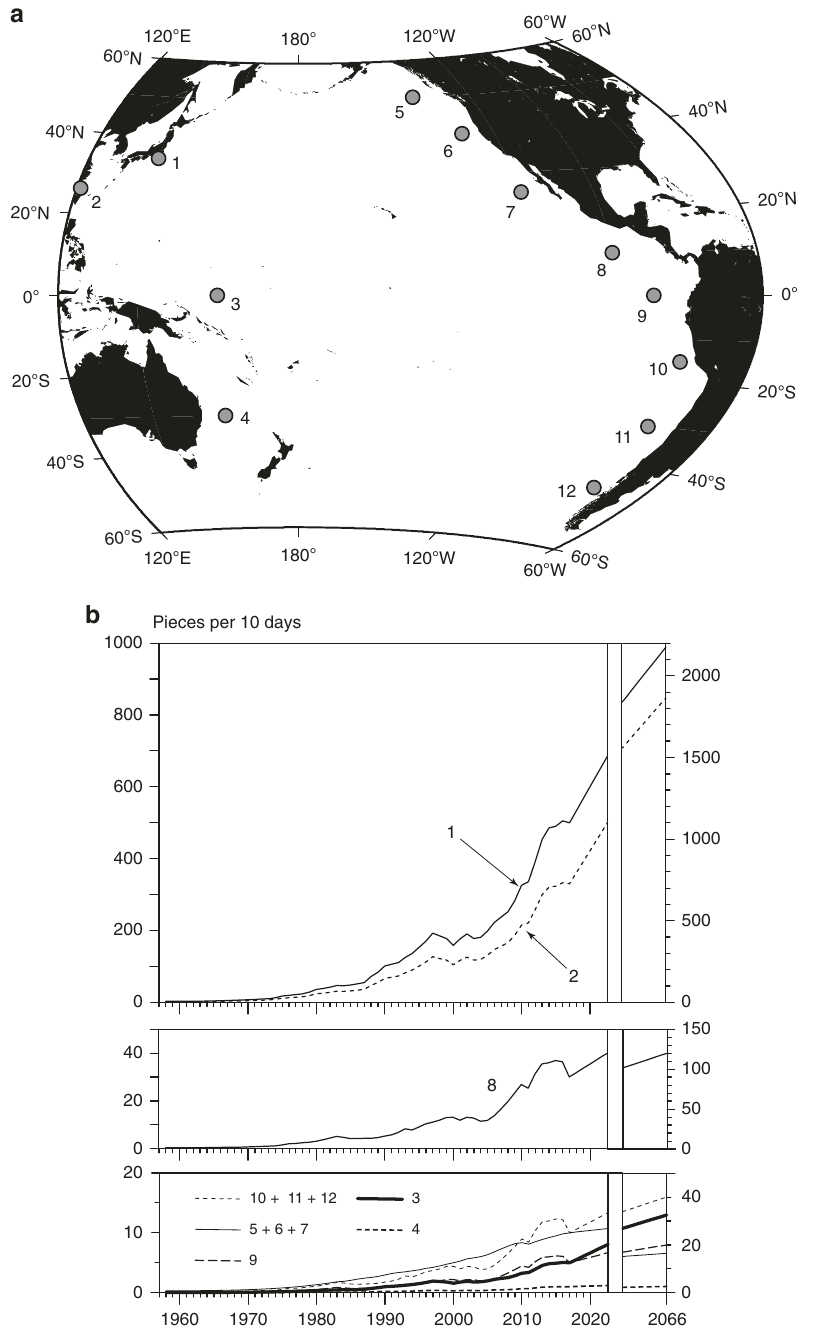
Fig. 2 Sources of microplastics in the numerical model. Source positions ( a ) and emissions ( b ) are shown for modeled particles representing microplastics during a 110-year computation. The combined emissions in North America (5 + 6 + 7) and South America (10 + 11 + 12) are plotted in